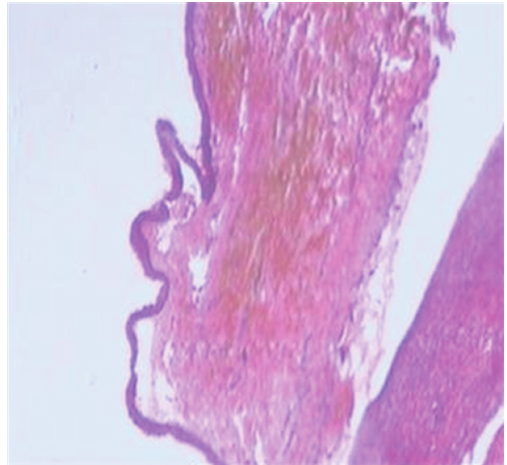
Figure 4: H&E stained section under scanner view shows flat epithelial-connective tissue interface, detachment of epithelial lining due to inflammation and folded epithelial